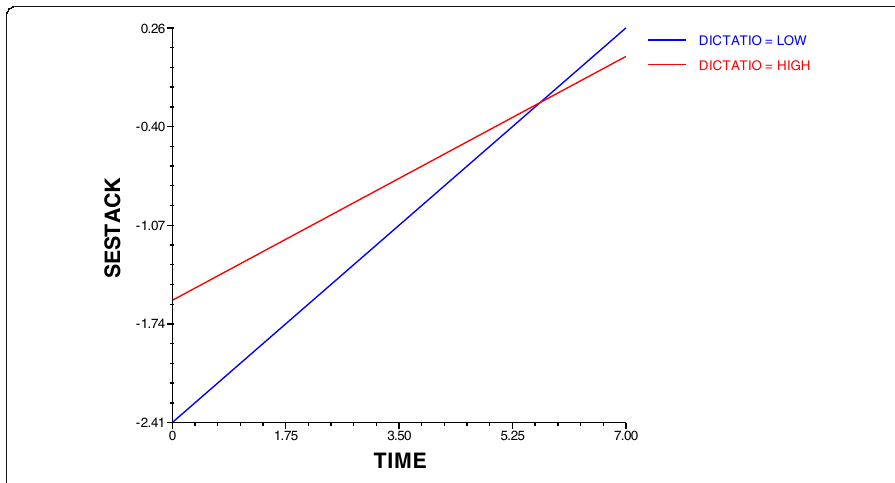
Fig. 2 Effect of English ability on individual gains in